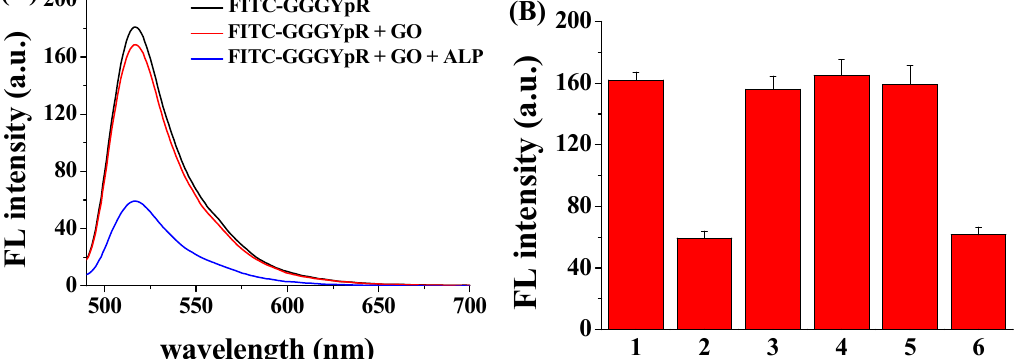
Figure 3. ( A ) Fluorescence spectra of FITC–GGGYpR in the presence of GO and ALP; ( B ) Fluorescence intensity of FITC–GGGYpR/GO in the absence (bar 1) and presence of ALP (bar 2), bovine serum albumin (BSA) (bar 3), lysozyme (bar 4), myoglobin (bar 5), and ALP/BSA/lysozyme/myoglobin (bar 6). The final concentrations of FITC–GGGYpR, GO, ALP, BSA, lysozyme and myoglobin are 100 nM, 50 μ g·mL − 1 , 10 nM, 0.5 μ g·mL − 1 , 0.5 μ g·mL − 1 and 0.5 μ g·mL − 1 , respectively.